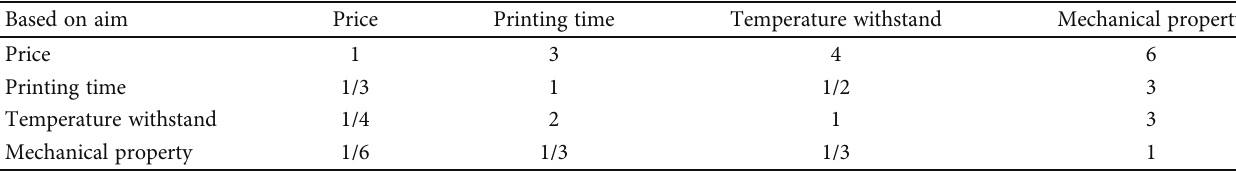
Table 4: Pairwise matrixes for analyzing criteria.